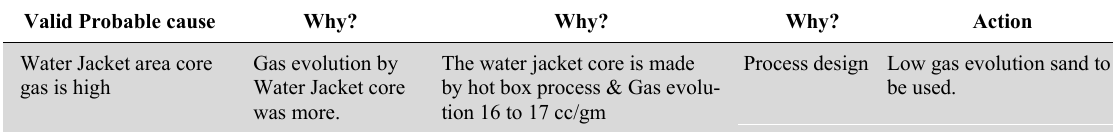
Identified root